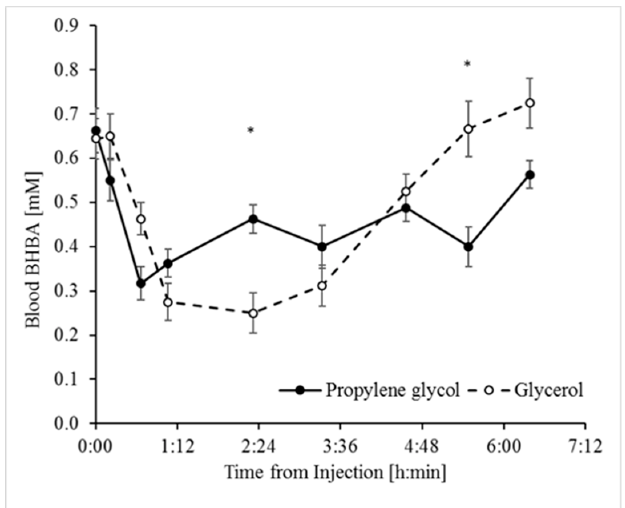
Figure 1. BHBA response to the propylene glycol and glycerol treatments. Analyses indicate significant effects of Treatment, Time, and Treatment × Time interaction (Table 1). * Significant difference at α = 0.00625 after Bonferroni correction. SEM = 0.03. Values represent mean ± SE. Table 2. Effect of intravenous infusion of glycerol and propylene glycol (PG) on the percentage delta (Delta %) and area under the curve (AUC) for concentrations of nutrients, metabolites, and hormones in the blood.